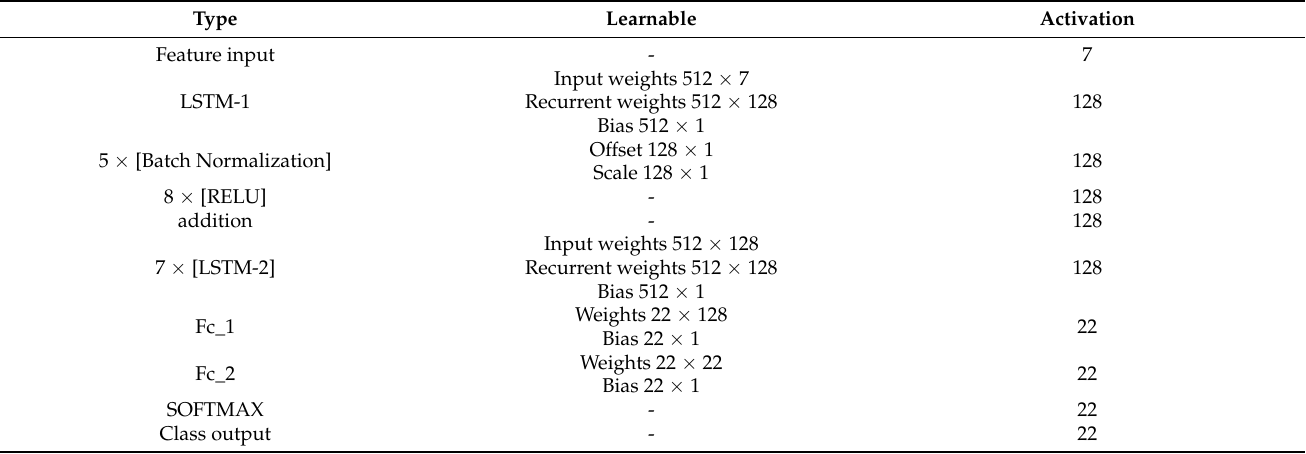
Table 2. Details of the proposed LSTM